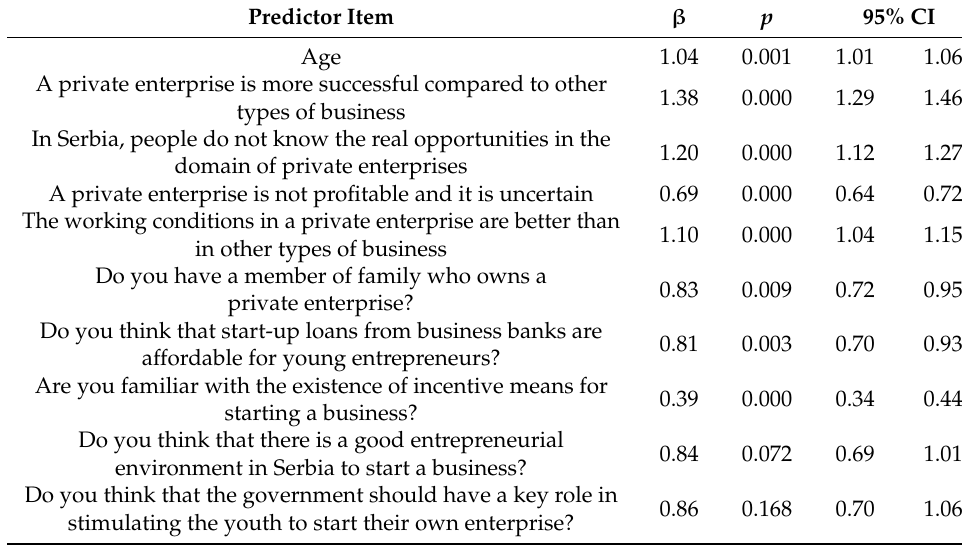
Table 6. Results of the binary logistic